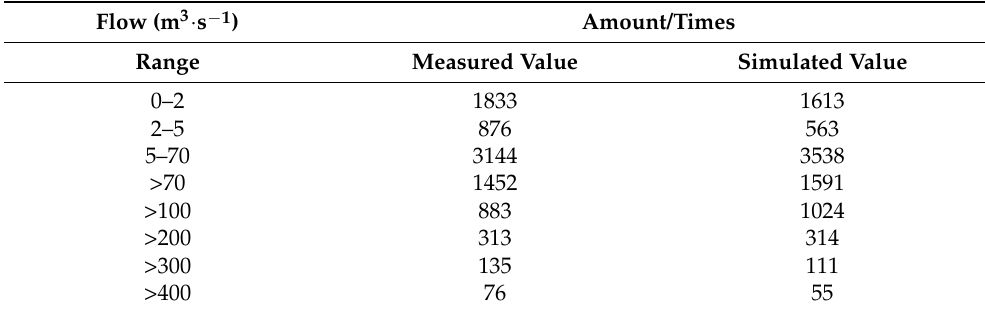
Table 5. The number of measured and simulated values of daily runoff at each water level from 1976 to 2019.